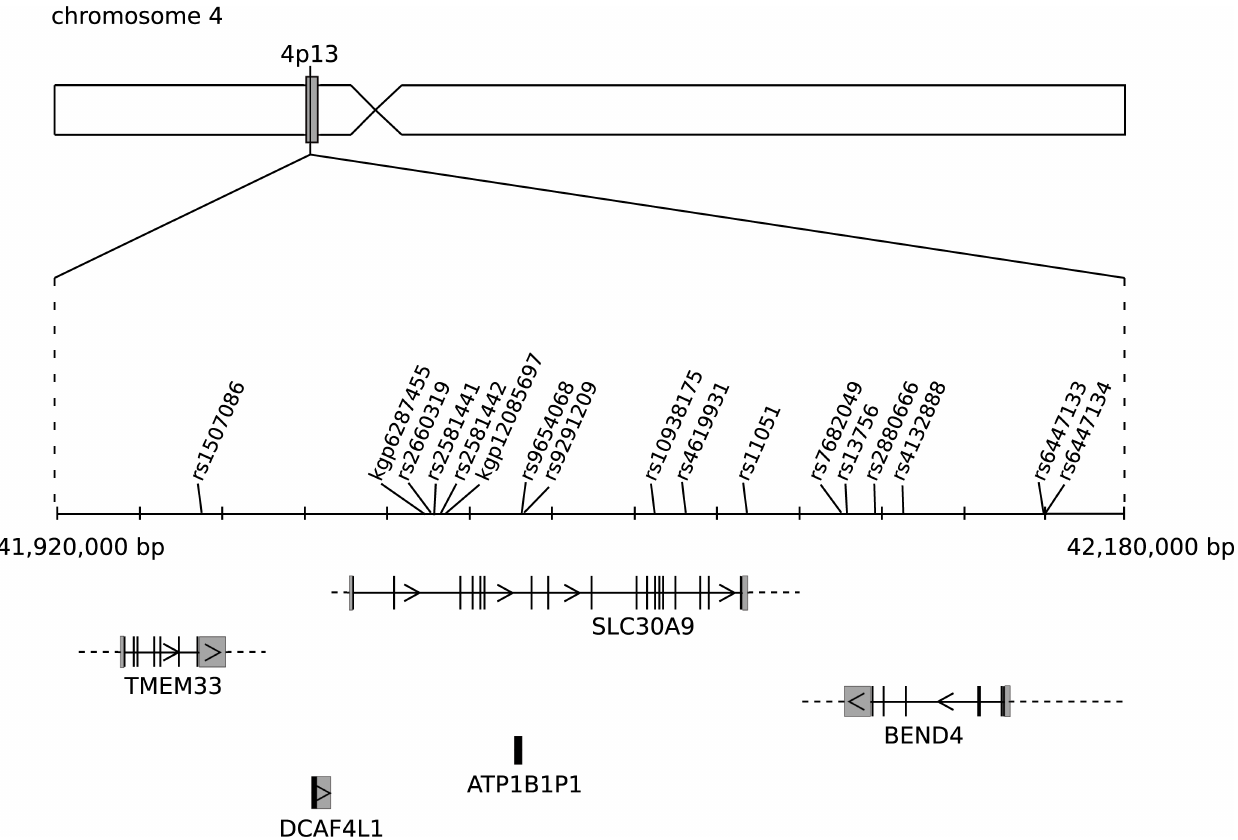
Fig 2. Schematic illustration of a region of 4p13. Within 215,932 base pairs, 17 single nucleotide polymorphisms (SNP) nearly reach genome-wide significance in association with self-reported helping behaviour. This area covers transmembrane protein 33 (TMEM33), DDB1 and CUL4 associated factor 4-like 1 (DCAF4L1), solute carrier family 30 (zinc transporter), member 9 (SLC30A9), ATPase, Na+/K+ transporting, beta 1 polypeptide pseudogene 1 (ATP1B1P1), and BEN domain containing 4 (BEND4). Black boxes depict exons, grey boxes are 5’ and 3’ untranslated regions.